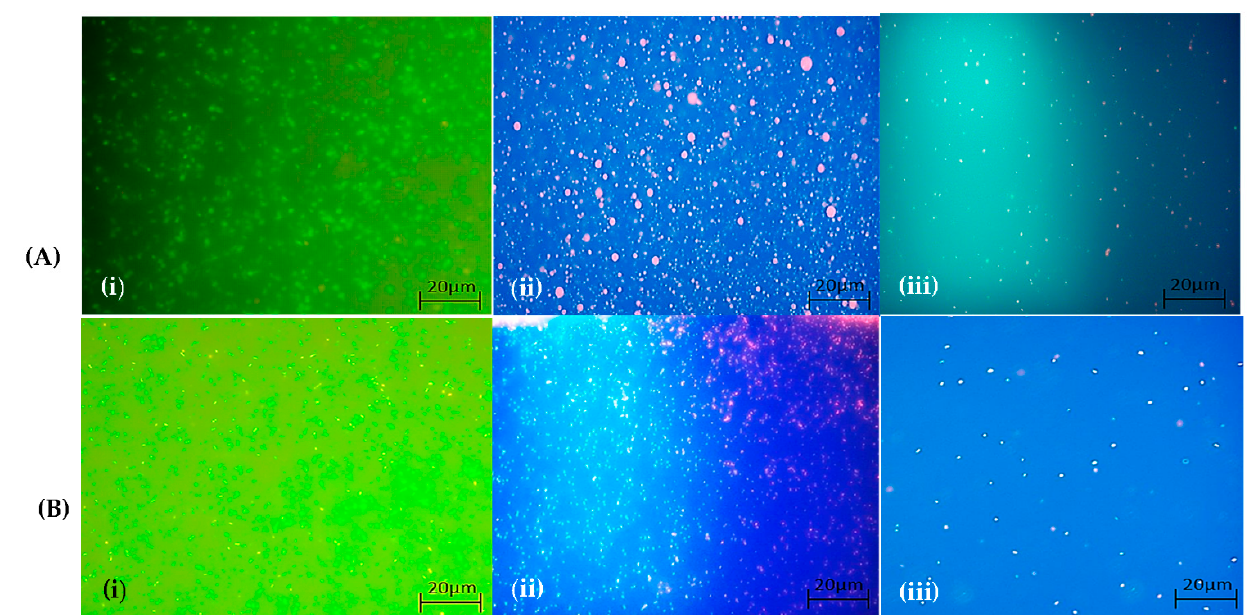
Figure 8. Inverted microscopy-based images of cells. ( A ) E. coli Castellani and Chalmers (ATCC35150) ( i ) without treatment,